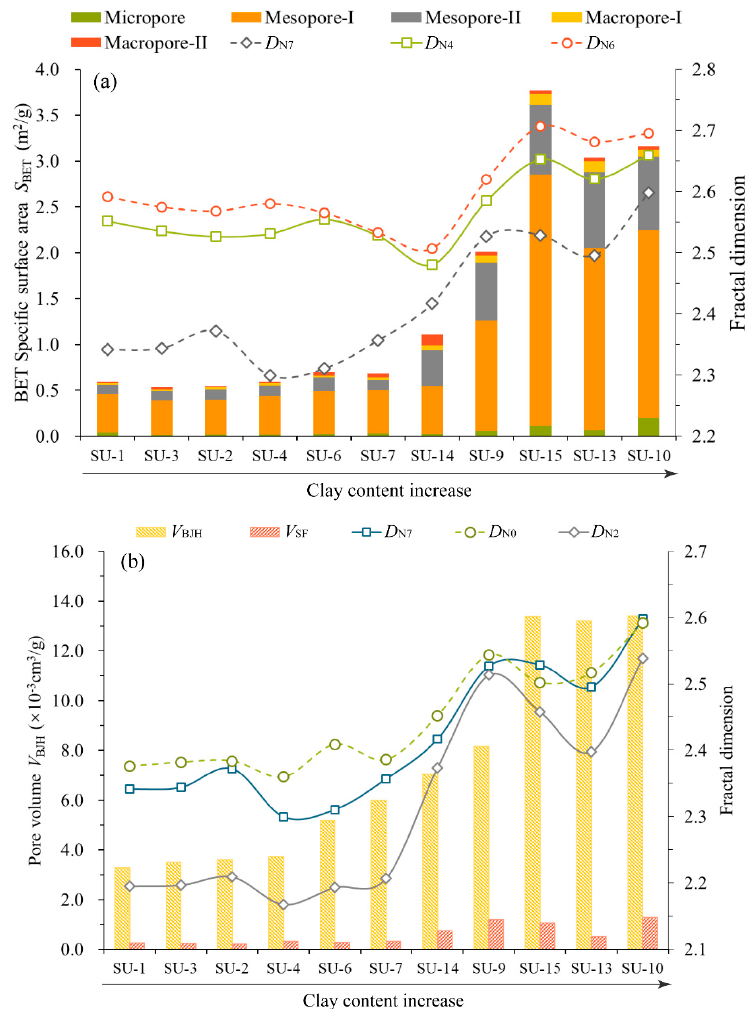
Figure 12. The relationship between pore structure parameter and Fractal dimensions in the order of clay mineral content increasing. ( a ) The relationship between S BET and fractal dimensions; ( b ) the relationship between PV and fractal dimensions.